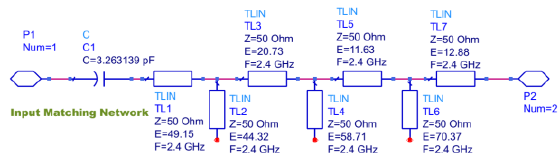
Fig. 10. Preliminary input matching network